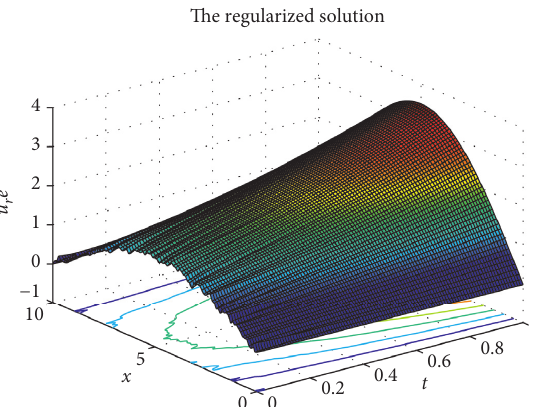
Figure 3: The regularized solution in the case of ε